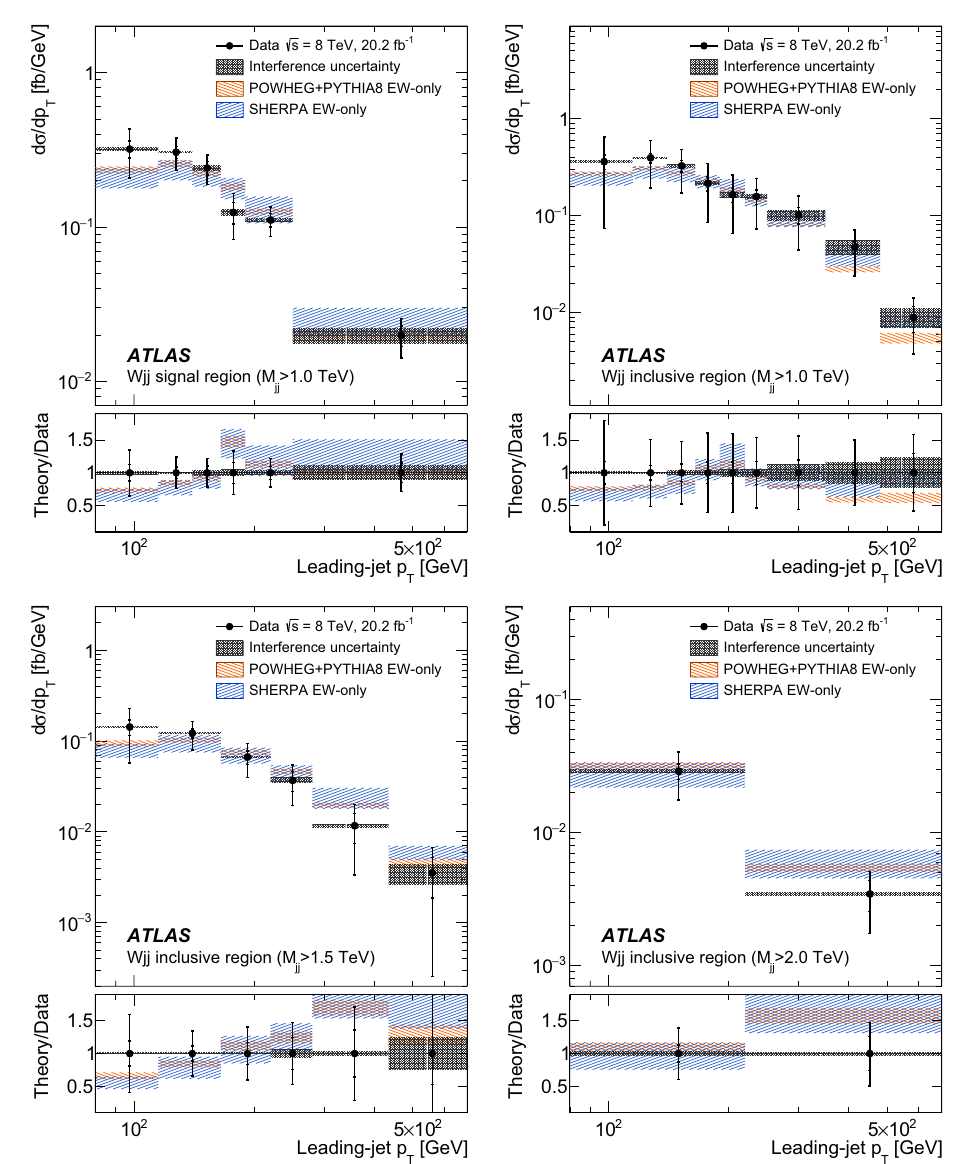
Fig. 43 Differential electroweak W jj production cross sections as a function of the leading-jet p T in the high-mass signal region and the inclusivefiducialregionwiththreethresholdsonthedijetinvariantmass